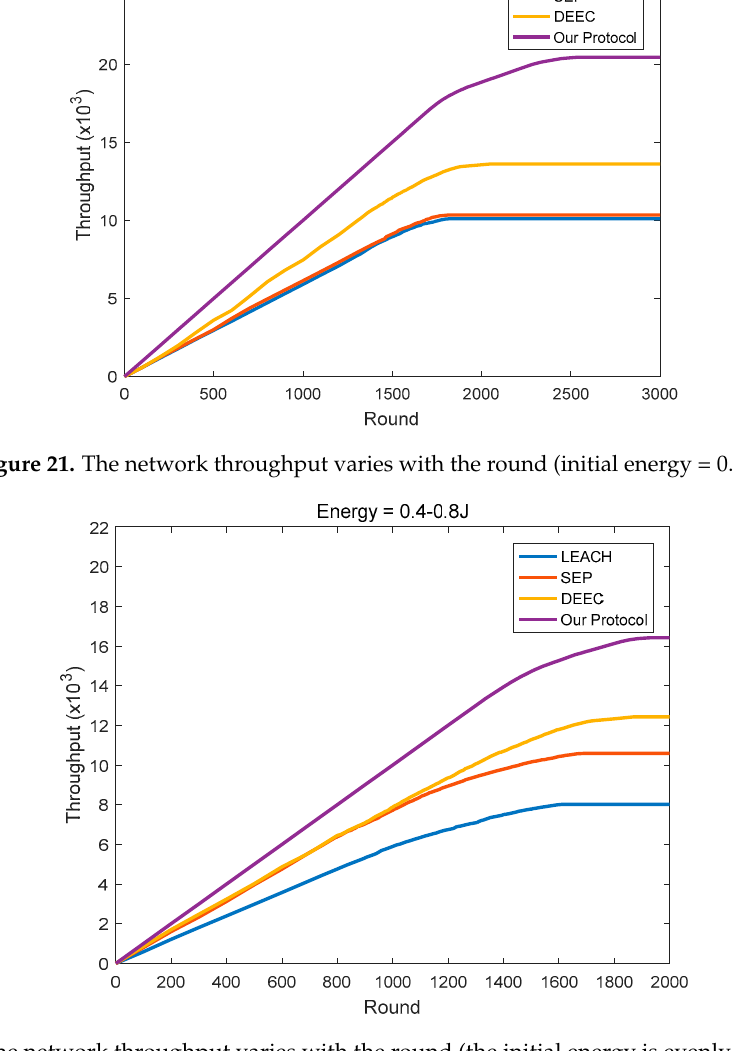
Figure 22. The network throughput varies with the round (the initial energy is evenly distributed at 0.4–0.8 J).